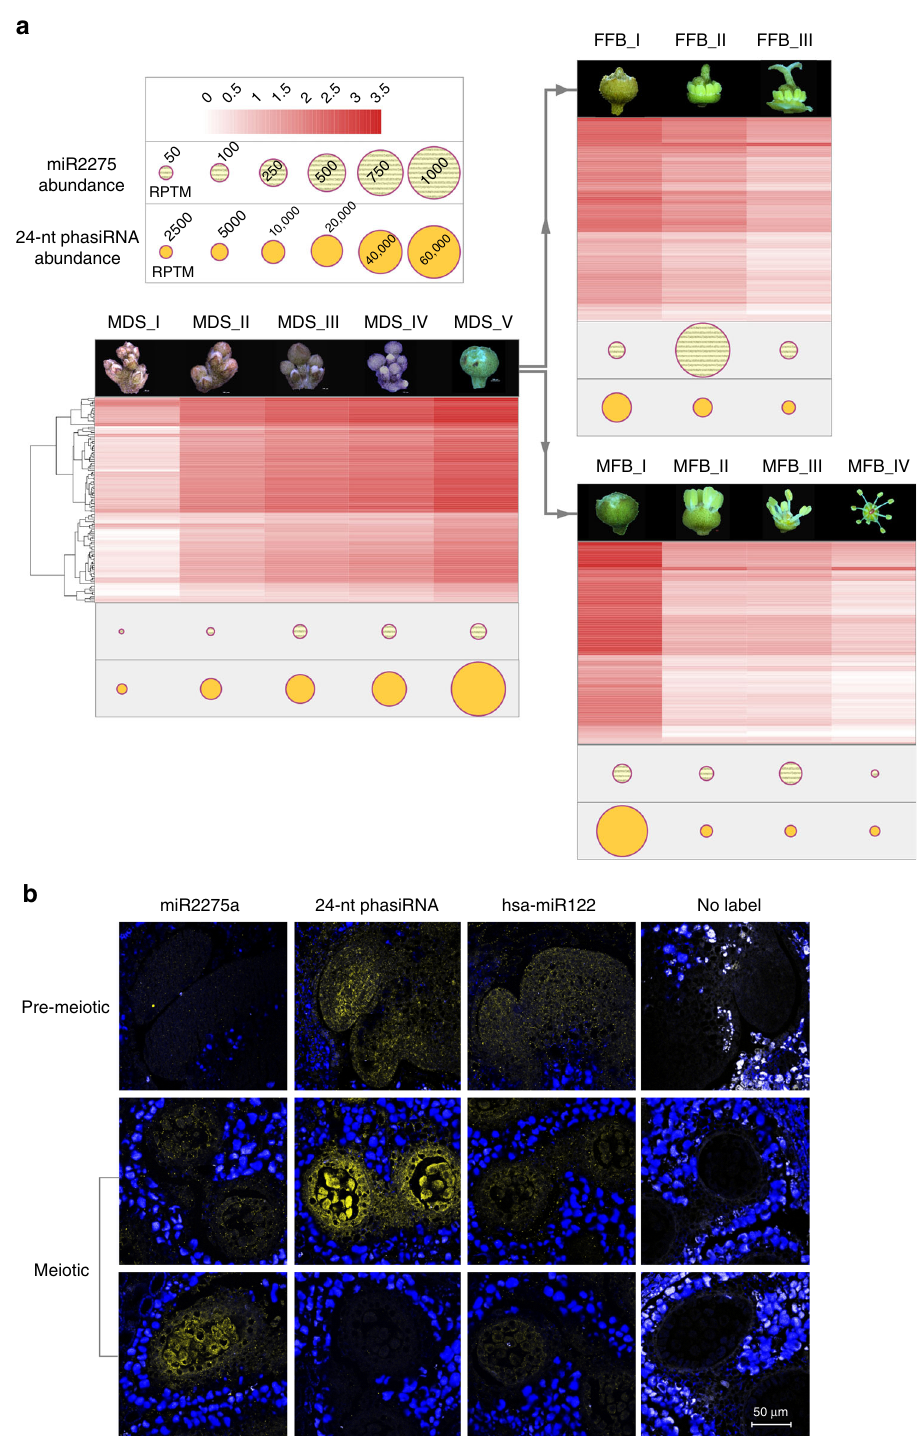
Fig. 2 Spatiotemporal patterns of accumulation of miR2275 and 24-nt phasiRNAs in litchi. a Abundances of miR2275 and 24-nt phasiRNAs as indicated in the key (upper left) across developmental stages of litchi fl owers. The heat map corresponds to the abundance of phasiRNAs at each 24- PHAS locus and dots indicate the summed abundances as indicated. MDS morphological differentiation stage, FFB female fl ower buds, MFB male fl ower buds. b In situ hybridization of miR2275 and a representative 24-nt phasiRNA in anthers from litchi fl ower buds. hsa-miR122 is a human miRNA used as a negative control, while the “ no label ” images have no labeled probe and serve as another negative control. Density of yellow denotes the sRNA hybridization signal; blue is auto fl uorescence of tissues surrounding the anthers. The diameter for litchi anthers increases as it develops from premeiotic to meiotic stage. At the premeiotic stage, the stamens are less than 1000 µ m in diameter. Scale bar = 50 µ m for all